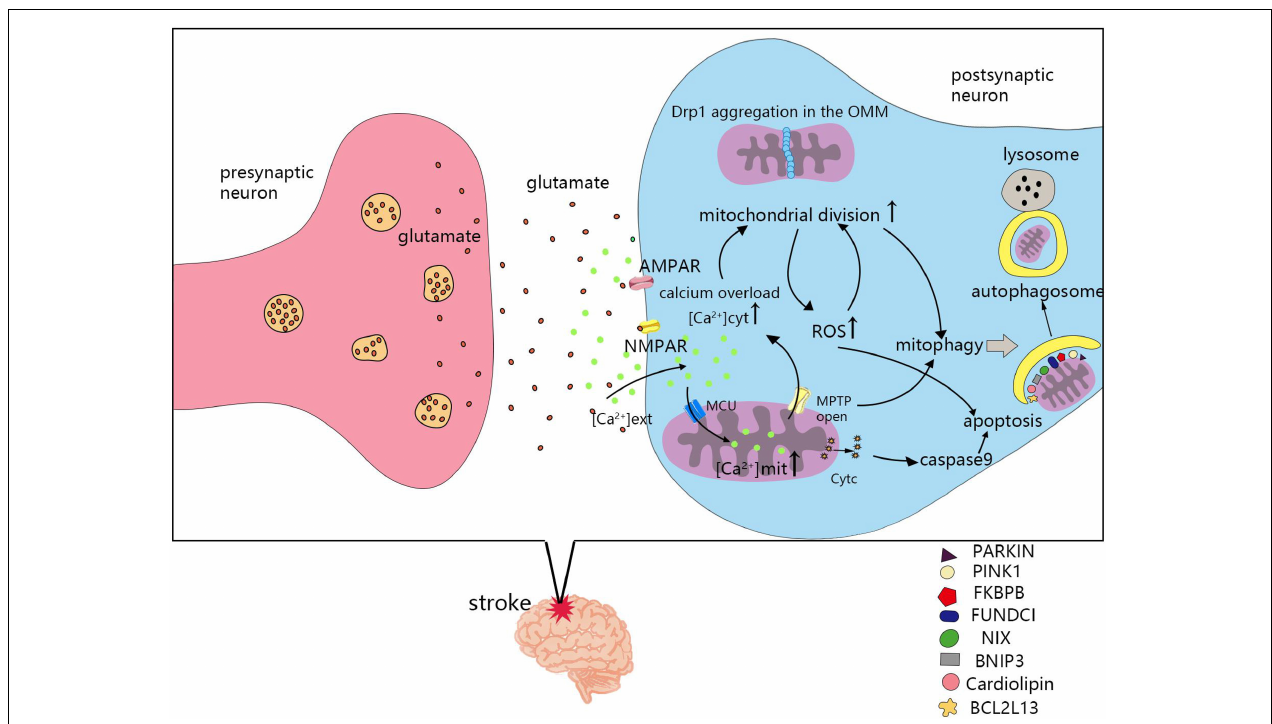
FIGURE 3 | Molecular mechanisms of mitochondrial dynamics in post-ischemic stroke injury. Cerebral ischemia and hypoxia lead to the imbalance of mitochondrial division and fusion, which is related to calcium overload, reactive oxygen species (ROS), mitochondrial permeability transition pores(MPTP), apoptosis, and mitophagy. MCU, mitochondrial calcium uniporter; NMPAR, N-methyl-D-aspartate receptors; AMPAR, α -amino-3-hydroxy-5-methyl-4-isoxazole-propionic acid receptors; [Ca 2 + ] ext, calcium ion concentration in extracellular; [Ca 2 + ] cyt, calcium ion concentration in cytoplasmic; [Ca 2 + ] mit, calcium ion concentration in